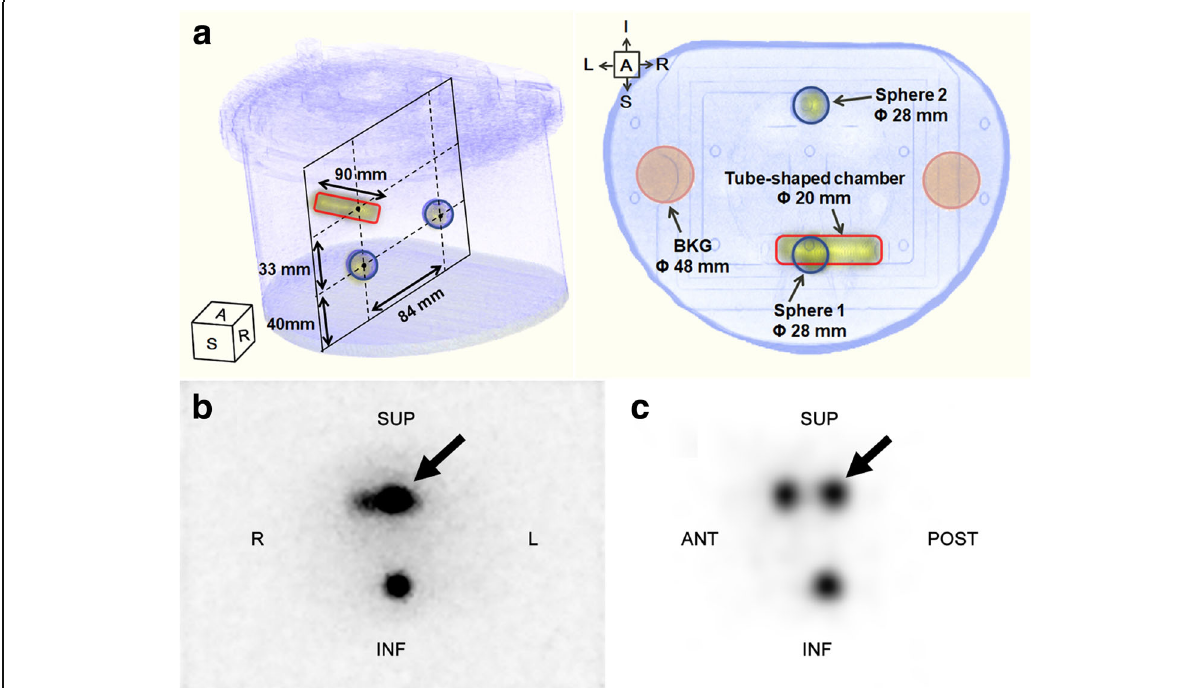
Fig. 2 Configuration of a modified body phantom simulating bowel activity and lumbar spine metastases ( a ). Uptake in sphere 1 (thick arrows) is overlaid with uptake of the tube-shaped chamber in the anteroposterior planar image ( b ) but not in the mid-sagittal plane of SPECT ( c ). Sphere 2 is used as reference. ANT anterior, SUP superior, POST posterior, INF inferior, R right, L left, BKG